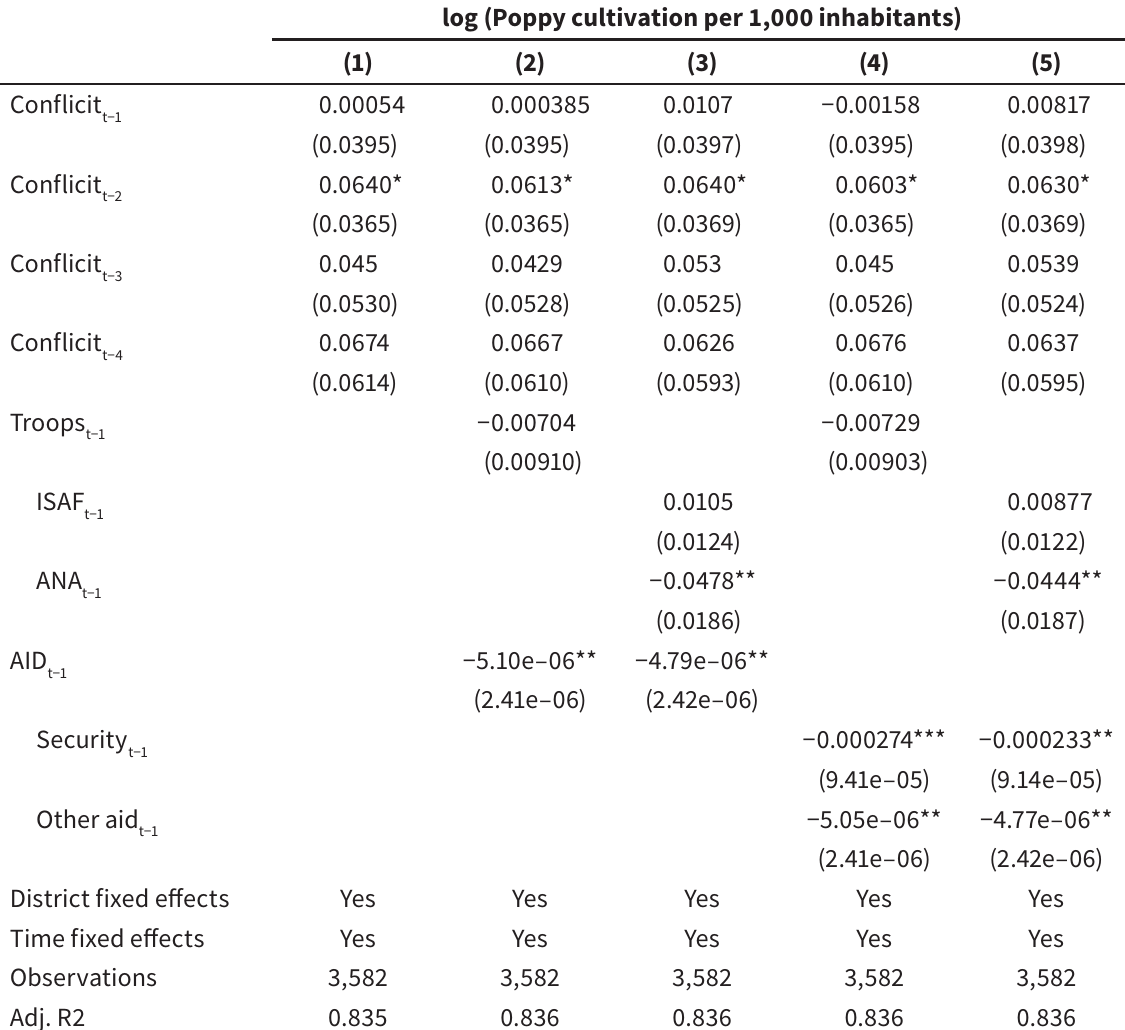
Conflict and land devoted to poppy cultivation log (Poppy cultivation per 1,000